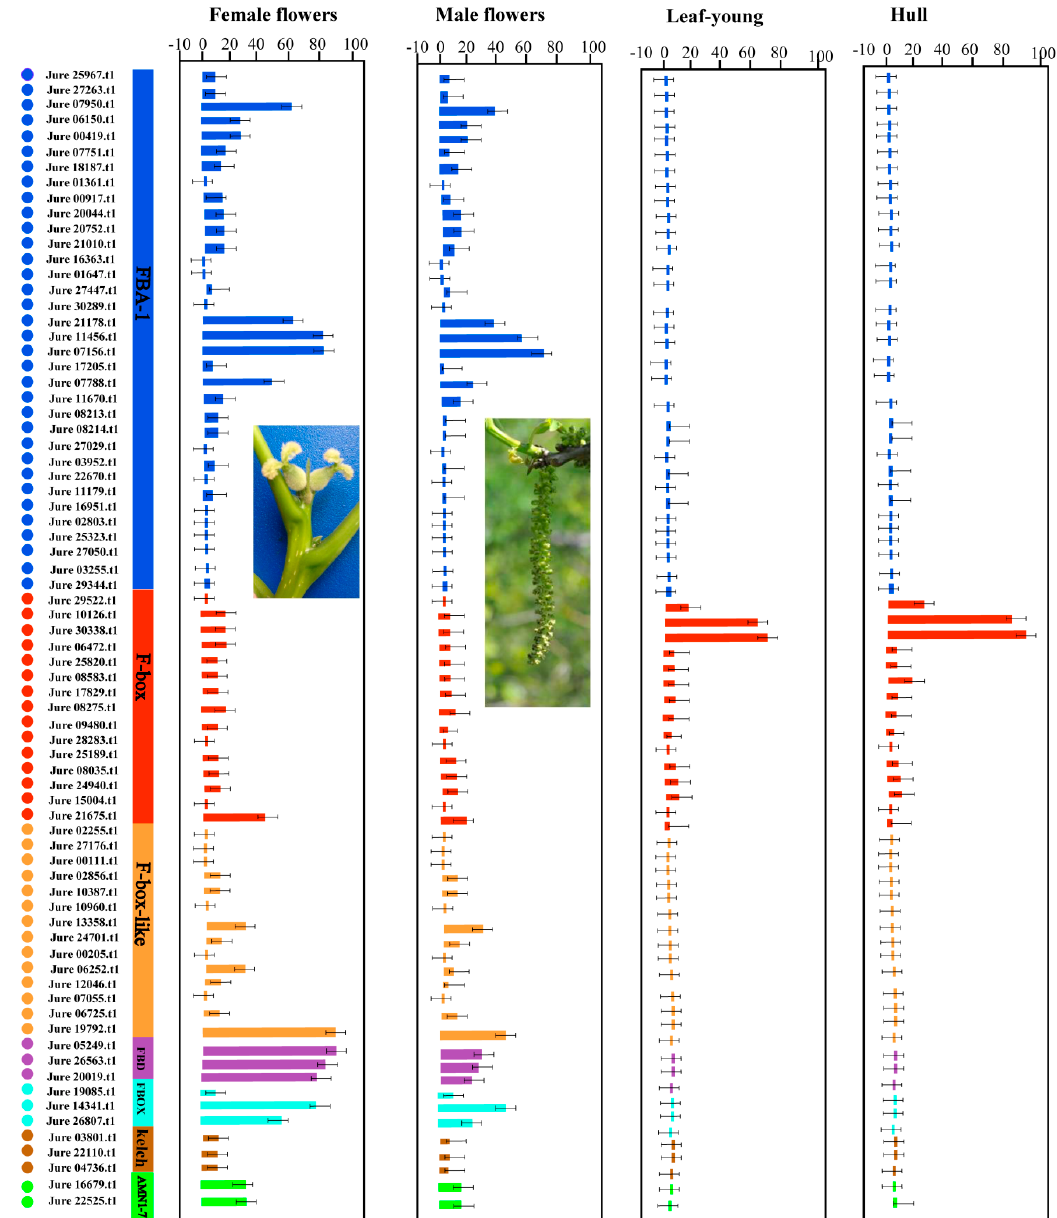
Figure 5. The values of F-box gene family member expression for different subfamilies of common walnut.